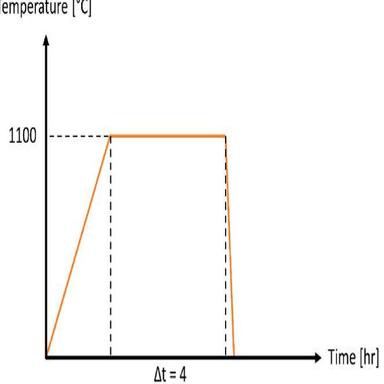
Time-temperature diagram for heat treatment process, simulating heat damage of Inconel 718. As the procedure was carried out at an external facility, the total ramp up time of the furnace to temperature is unknown; however, documentation provided confirms the sample was held at temperature for the required 4 h.